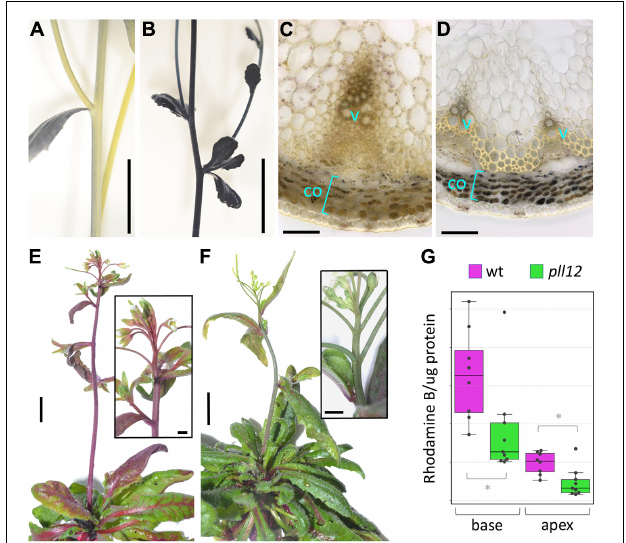
FIGURE 4 | PLL12 is required for both phloem and xylem function. (A,B) : inflorescence stems of wt (A) and pll12-1 (B) stained with Lugol’s solution, showing accumulation of starch in the mutant; scale bars: 1 cm. (C,D) : transversal sections of wt (C) and pll12 (D) stems stained with Lugol’s solution, showing accumulation of starch grains in cortex cells (co) in the mutant; scale bars: 50 µ m. (E,F) : wt (E) and pll12-1 (F) plants grown for 20 h with their roots immersed in rhodamine B solution; the dye was transported efficiently throughout the wt inflorescence, whilst the mutant stems transported far less dye to the apex; insets show the inflorescence apices at a higher magnification; scale bars: 1 cm (main panels), 250 µ m (insets). (G) : Boxplots showing Rhodamine content (normalised to protein concentration to correct for differences in tissue mass) in the apical and basal 1 cm segments of wt (magenta) and pll12-1 (green) stems; * indicate significant differences ( p < 0.05, Mann-Whitney test; full statistical analysis in